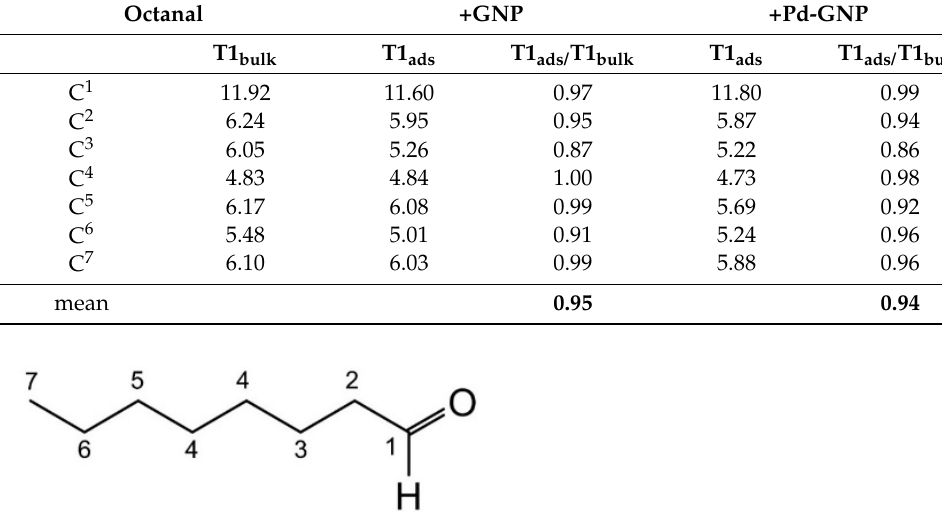
Figure 7. Differentiation of n-octanal carbon atoms detectable by T1 13 C NMR. Table 5. Octanal in p -Xylene-d 10 : T1 bulk and T1 ads resulting from analysis of the inversion recovery curves (Figures S4–S6) from 13 C NMR spectra in high-field (600 MHz).